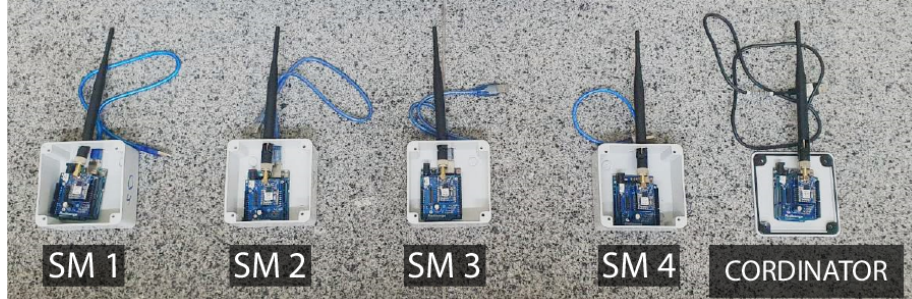
Figure 12. LoRaMESH implementation